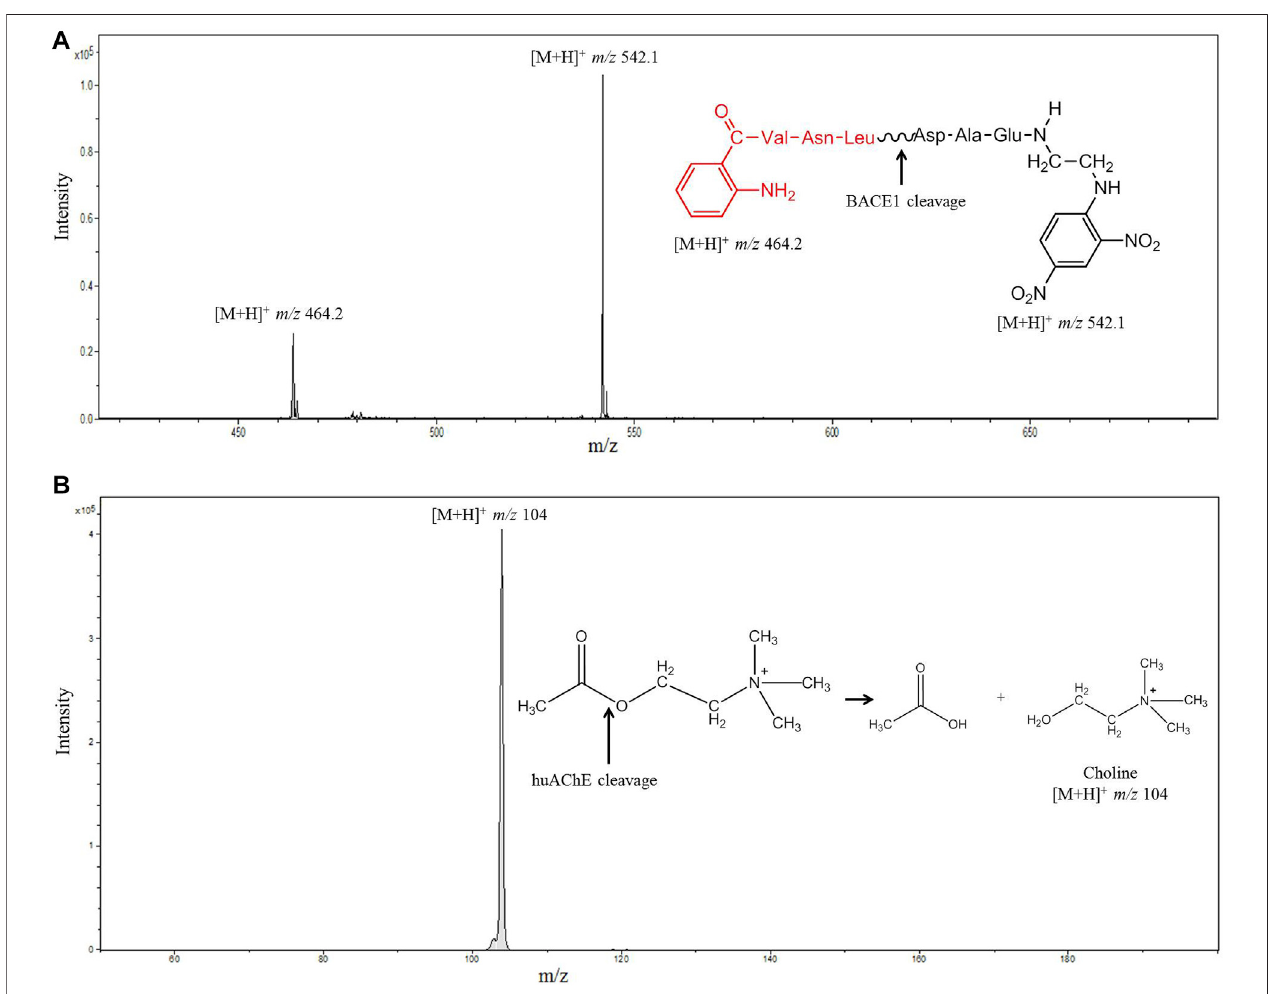
FIGURE5| MassspectrumobtainedafterinjectionofJMV2236(100 µM)intothehuAChE+BACE1-ICER-LC-MSsystem. (A) Theproductofenzymatichydrolysis ([M+H] + m/z 464.2 and 542.1) wasmonitored. (B) Massspectrum obtained after injection ofACh (70 µM) into the huAChE+BACE1-ICER-LC-MS system by monitoring the product of enzymatic hydrolysis ([M+H] + m/z 104) (Conditions listed in Table 1 ).